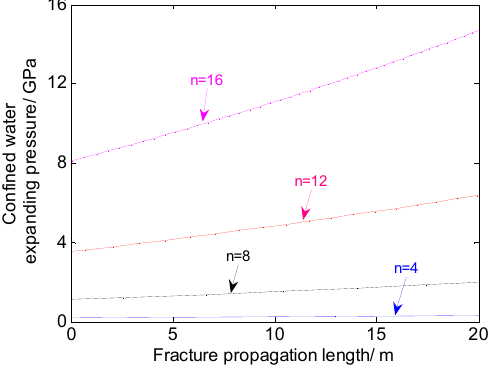
Figure 8. Effect of expansion of confined water on fracture propagation.